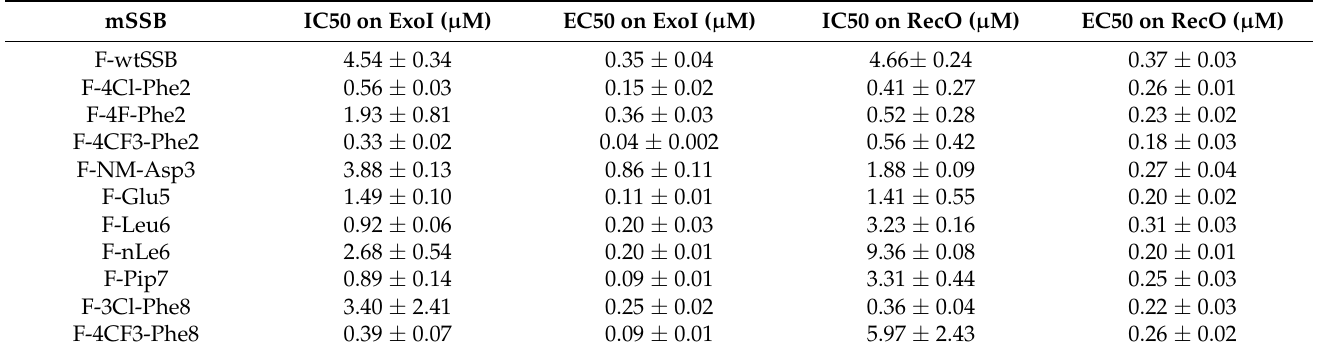
Table 2. Results of direct fluorescence anisotropy titrations with ExoI and RecO. IC50 values are shown for